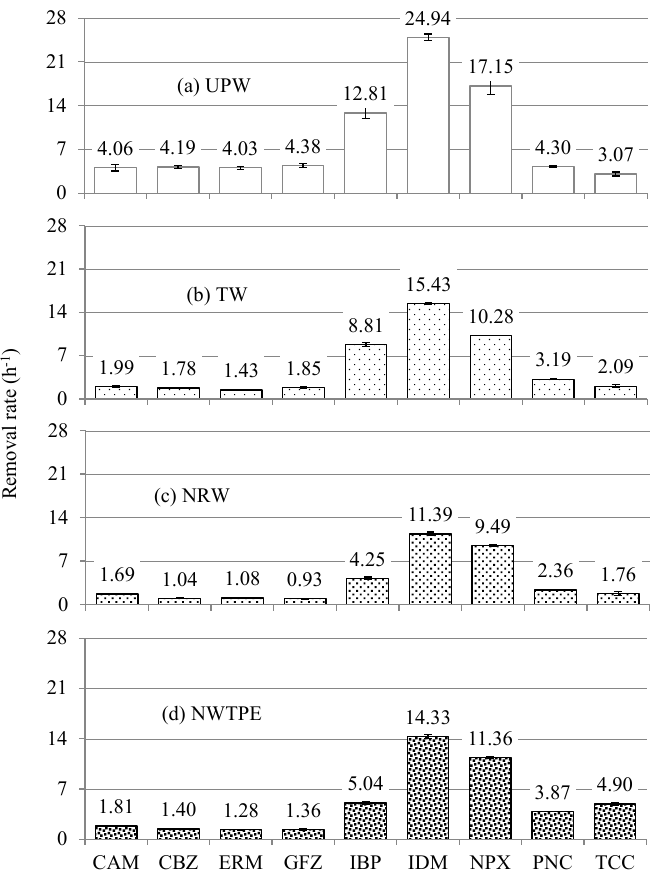
Figure 5. Pseudo first-order removal ratios for PhCs (n = 3, 30 min reaction) by VUV photolysis in simulated mixed solutions using ultrapure water (UPW), tap water (TW), Neya River water (NRW) and Nakahama wastewater treatment plant effluent (NWTPE). Other seven PhCs with over 99% removal ratios by UVC photolysis are not shown